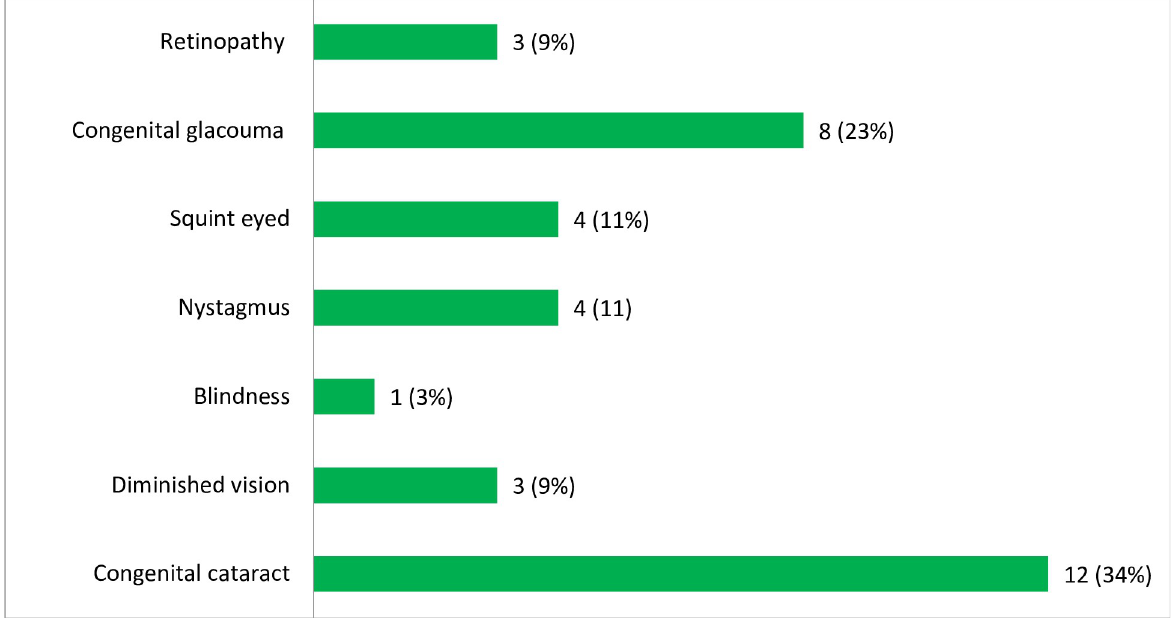
Fig 2. The frequency of different ocular manifestations among infants suspected for CRS in Amhara Regional State Referral Hospitals, Northwest Ethiopia, December 2015-August 2017.